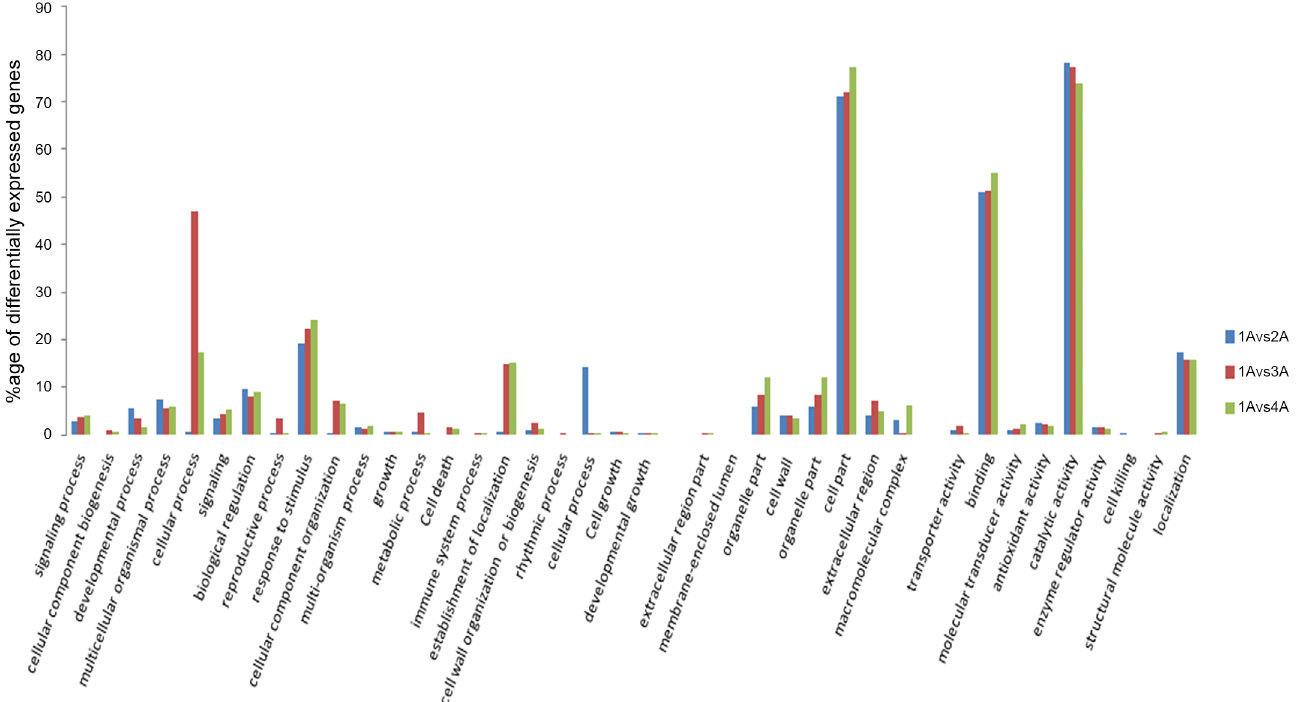
Fig 3. Differentially expressed genes in Molecular function, Cellular component and Biological